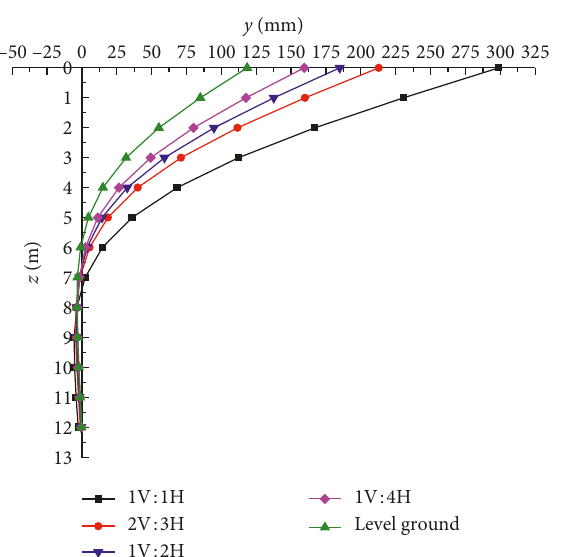
Figure 8: Pile deflection versus depth relationships of different slope ratios for H 0 (cid:31)